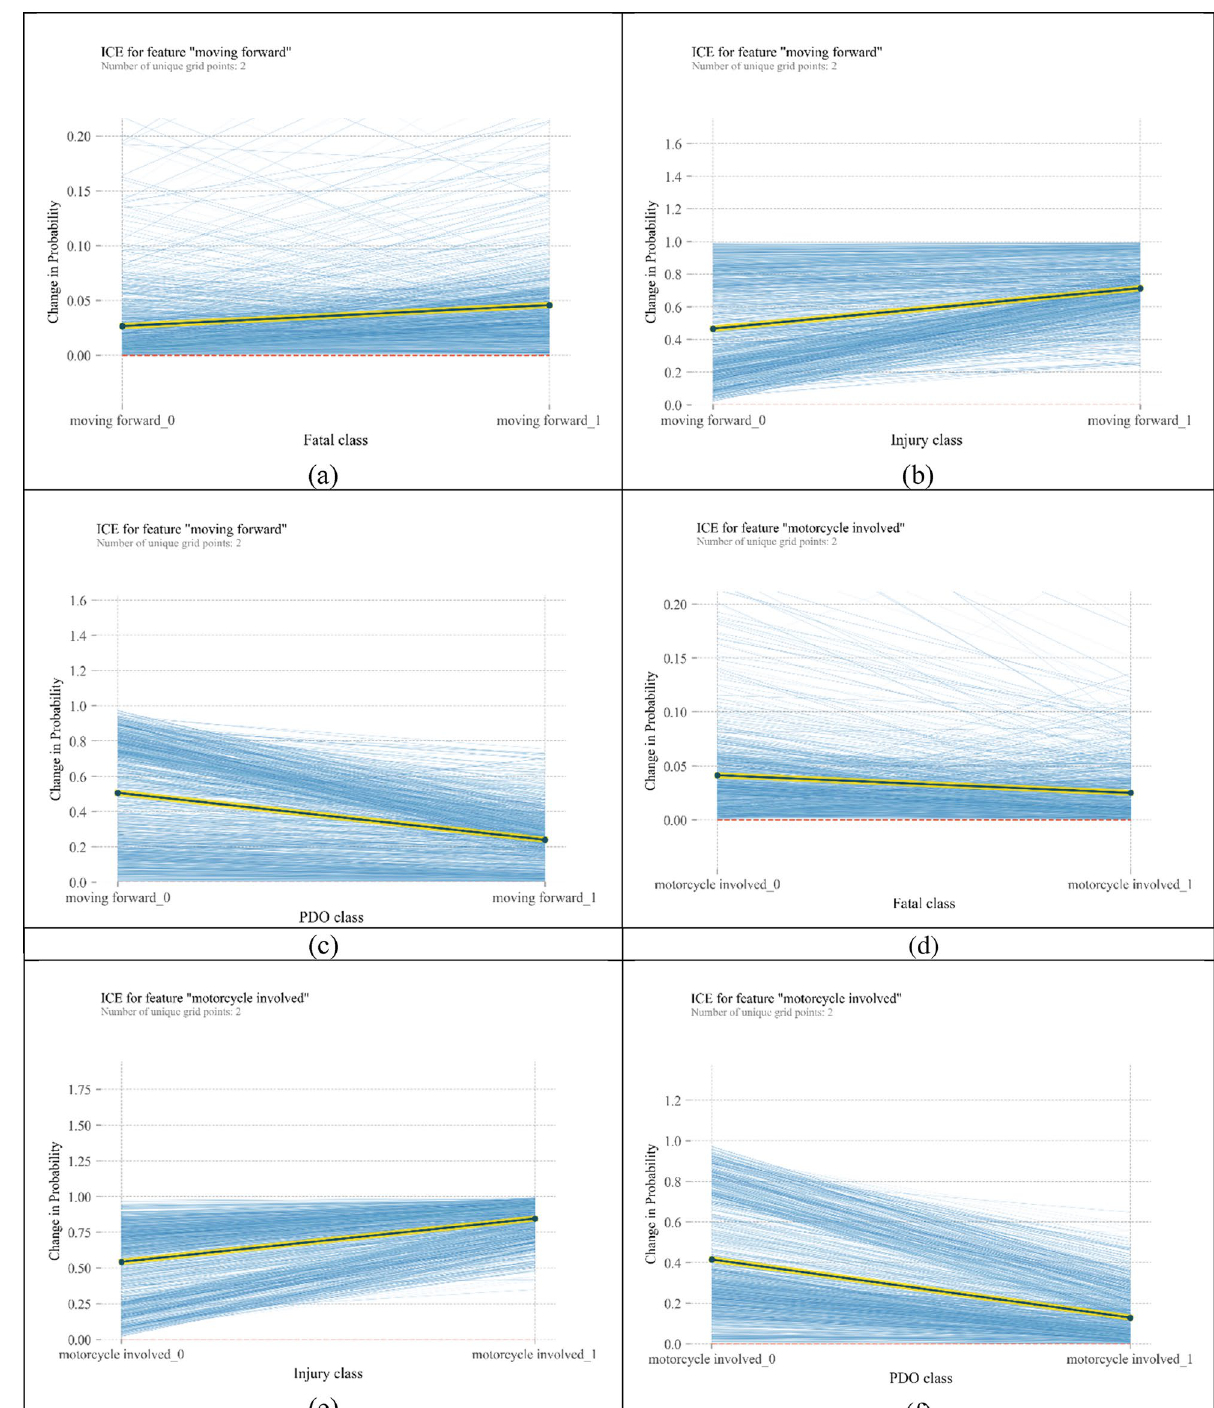
Figure 5. ICE plots for the most influencing variables on crash severity [plotted by Python Matplotlib v. 3.3.4 https:// matpl otlib.